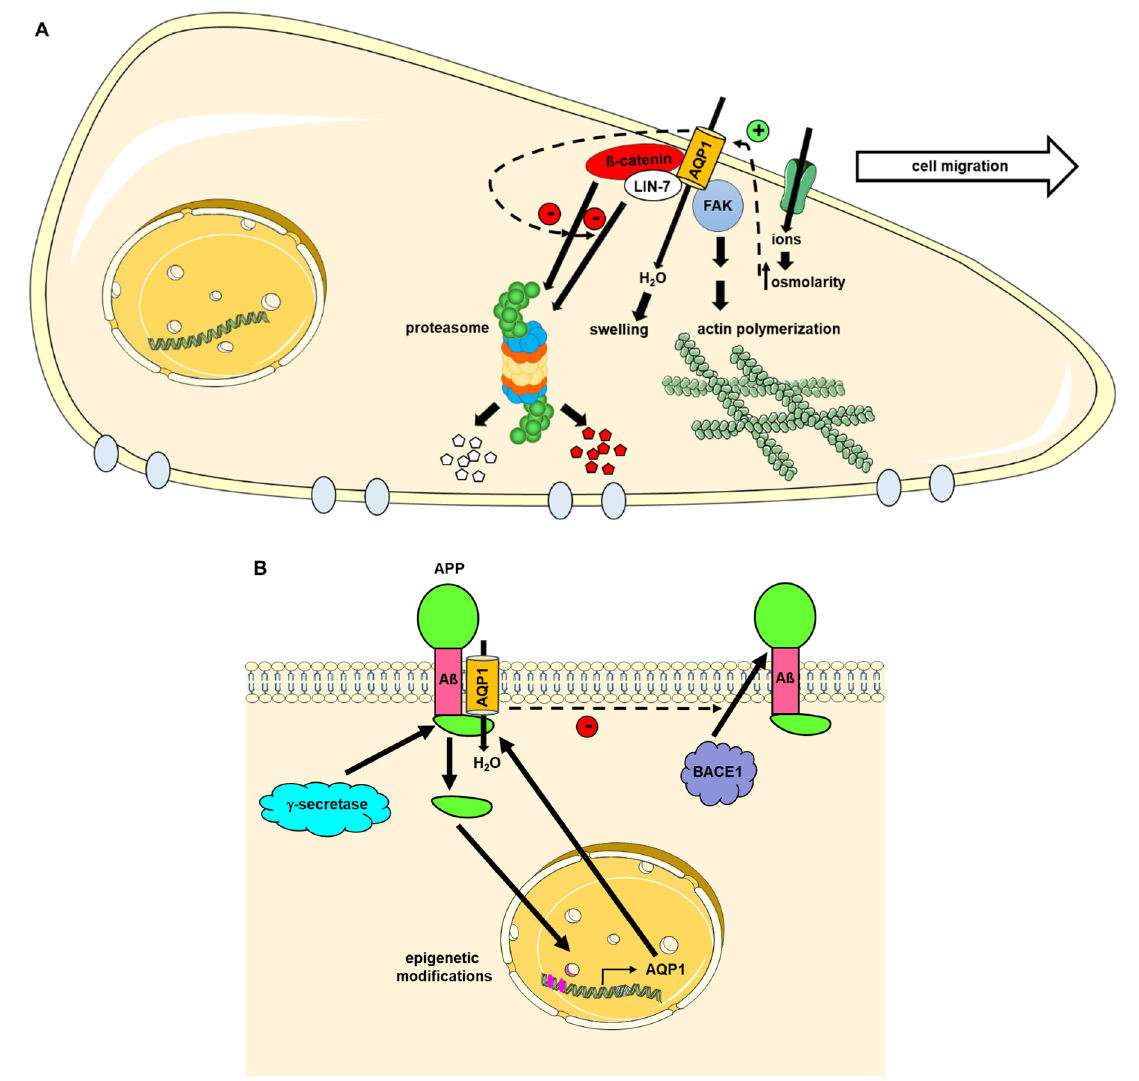
Figure 3. Role of the protein–protein interactions involving AQP1. ( A ) Role in cell migration. During cell migration, increased ion transport at the leading edge of the cells raises intracellular osmolarity that subsequently drives water entry through AQP1. AQP1 binding to FAK, LIN-7 and ß-catenin promotes actin polymerization, at least partly by inhibiting LIN-7 and ß-catenin degradation through the proteasome. ( B ) Role in APP accumulation in Alzheimer’s disease. AQP1 interaction with APP reduces the binding of BACE1 to APP and inhibits the release of Aß. In addition, the N-terminus of APP released by γ -secretase induces epigenetic modification, leading to increased AQP1